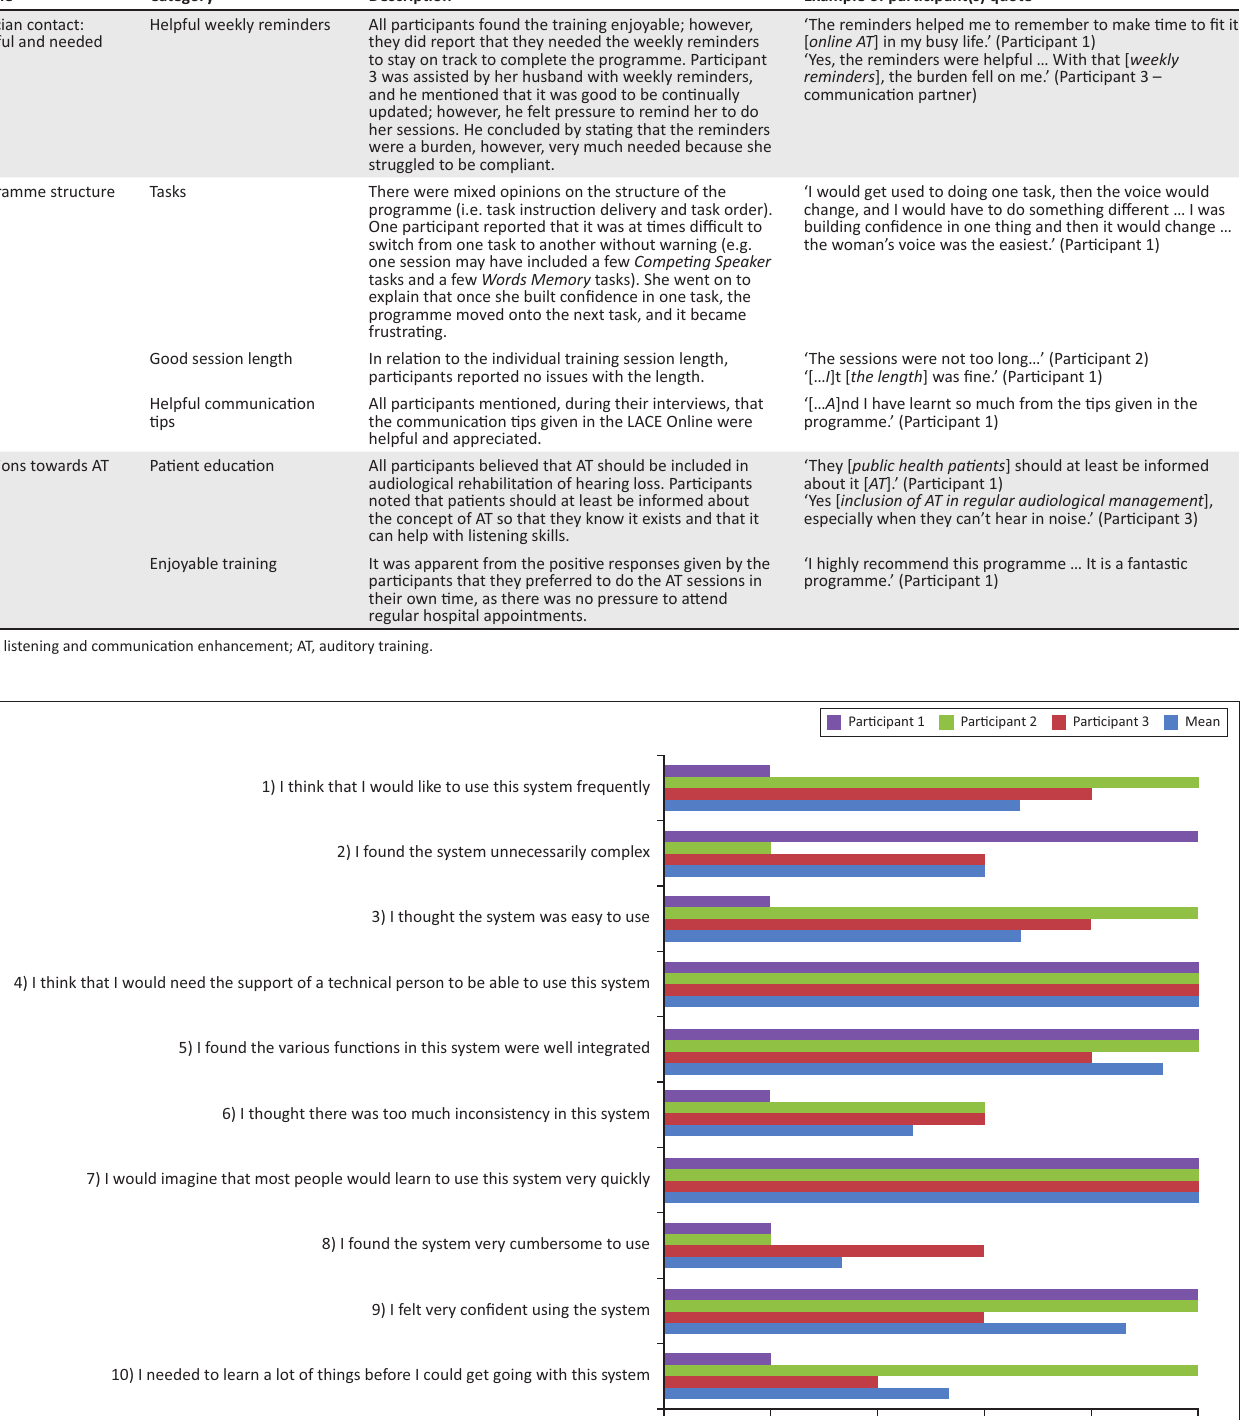
TABLE 6: Thematic analysis. Theme Category Description